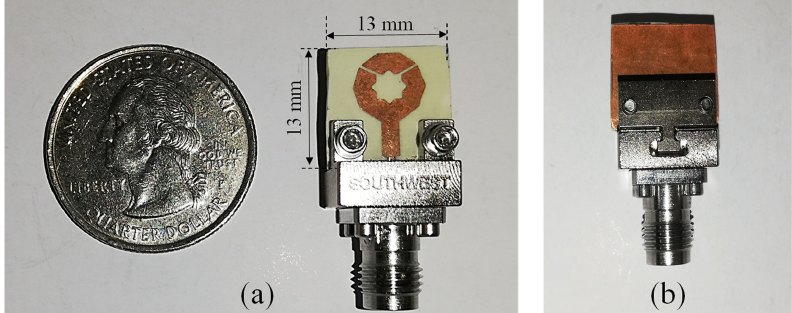
Figure 8. Fabricated antenna; ( a ) Front view, and ( b ) back view.